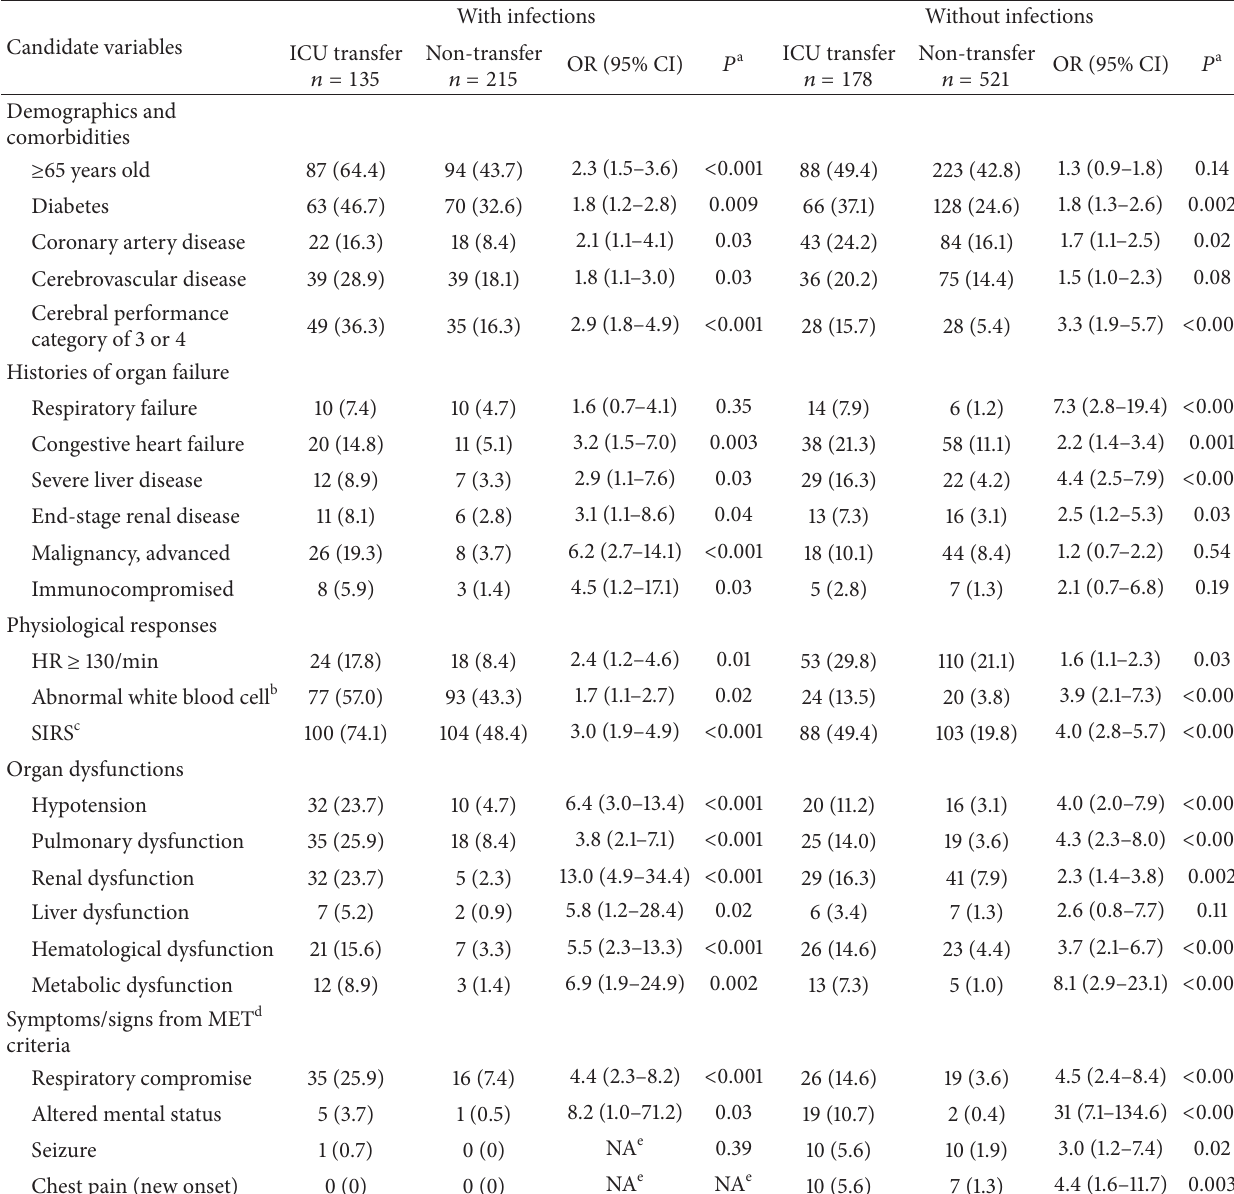
Table 3: Risk of deterioration in patients with infections and those without